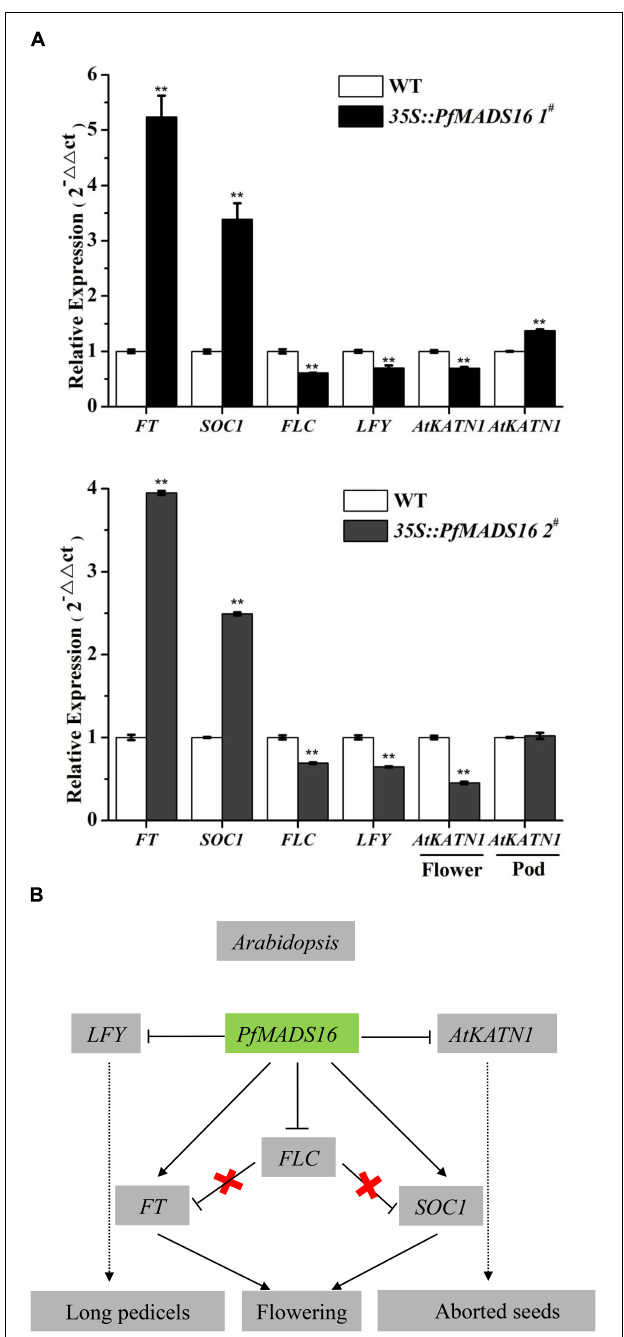
FIGURE 6 | Overexpression of PfMADS16 promotes flowering in Arabidopsis. (A) RT-qPCR analysis of PfMADS16 and the four endogenous flowering-related genes ( FT , SOC1 , FLC , LFY ) in whole above-ground material of the two transgenic Arabidopsis lines and WT at the early flowering stage, analysis of AtTKN1 in flowers and pods of transgenic and WT plants. The ACTIN2 gene was used as an internal control. ** indicates significant difference, p < 0.01. (B) Proposed model of flowering induction in PfMADS16 transgenic Arabidopsis plants. FLC , Flowering locus C; SOC1 , Suppressor of over-expression of CO1; FT , Flowering locus T; LFY , LEAFY; Arrow, enhanced expression; Horizontal line, inhibited expression; Cross, interrupted expression; Dotted line, indirect promotion.